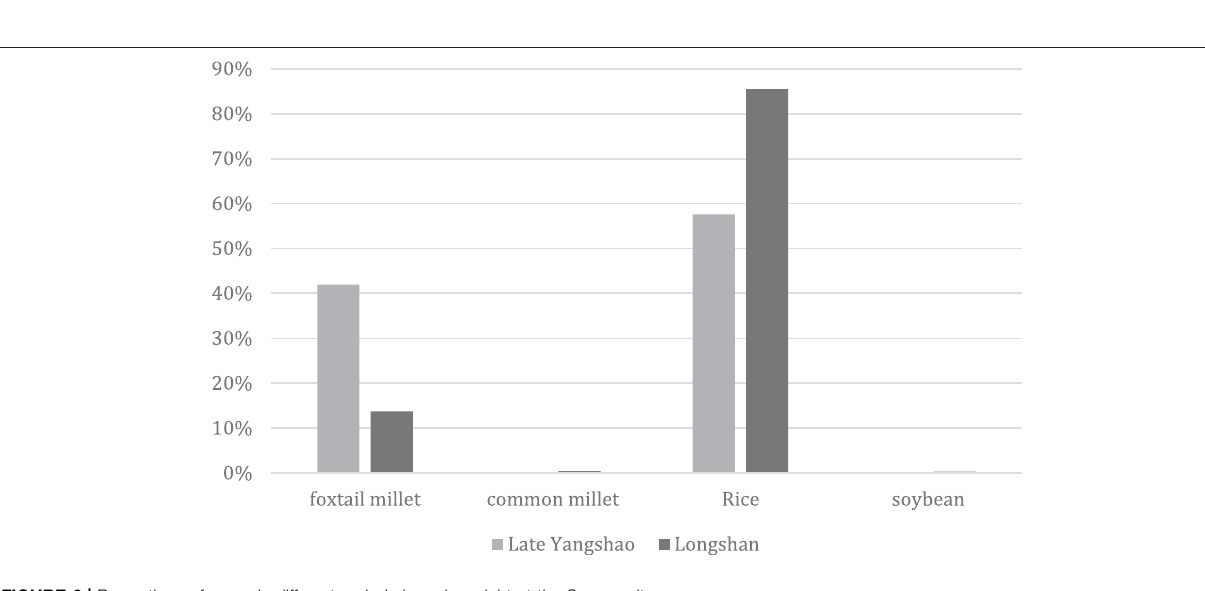
Frontiers in Earth Science |